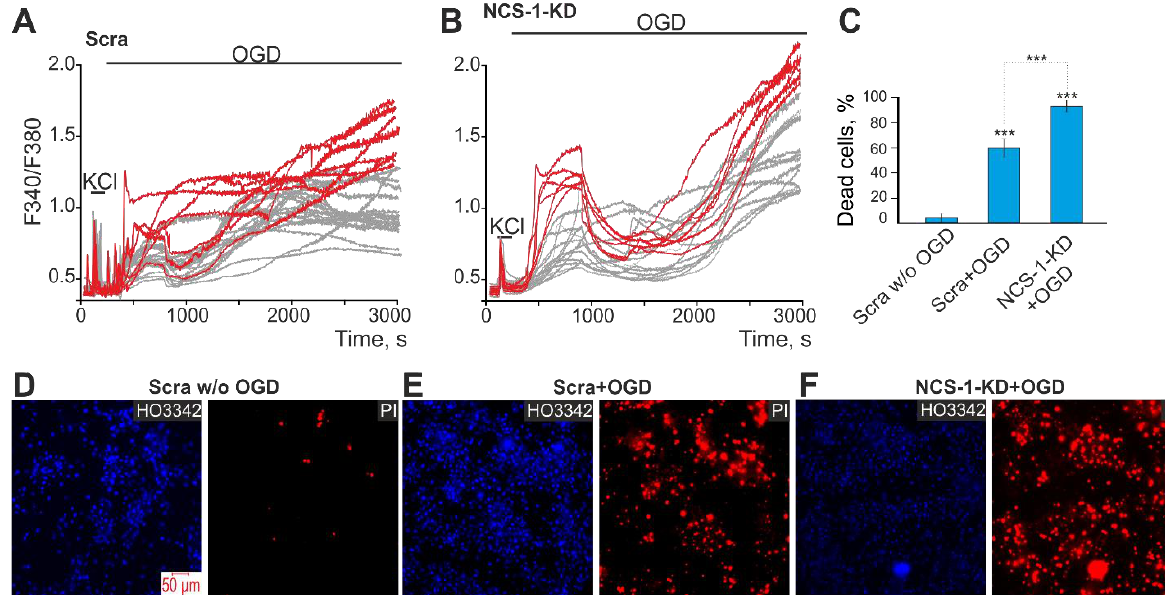
Figure 5. Effect of NCS-1-KD on OGD-induced Ca 2+ -signals of non-GABAergic (GAD65/67 – ) and GABAergic neurons of the cerebral cortex and their death. ( A , B ) Ca 2+ -signals of GABAergic (red curves) and GAD65/67 – (gray curves) neurons during a 40-min OGD in control (Scra, ( A )) and after NCS-1-KD (NCS-1-KD, ( B )). ( C ) The average number of PI-stained cortical cells that died due to OGD-induced necrosis in the Scra-group and NCS-1-KD-group. Statistical significance was assessed using paired t-test. Comparison Scra + OGD and NCS-1-KD + OGD with Scra w/o OGD significant, *** p -level < 0.001. ( D – F ) Images of cortical cell culture in the Hoechst 33,342 (HO342) and Propidium Iodide (PI) fluorescence detection channel in the experimental group without OGD (( D ) Scra w/o OGD) and after 40-min OGD treatment in Scra group (( E ) Scra + OGD) and neuronal calcium sensor-1 knockdown group (( F ) NCS-1-KD + OGD). The red dots represent the PI-stained nuclei of necrotic cells. The number of samples is 6. N (number of animals used for cell cultures preparation) = 3.